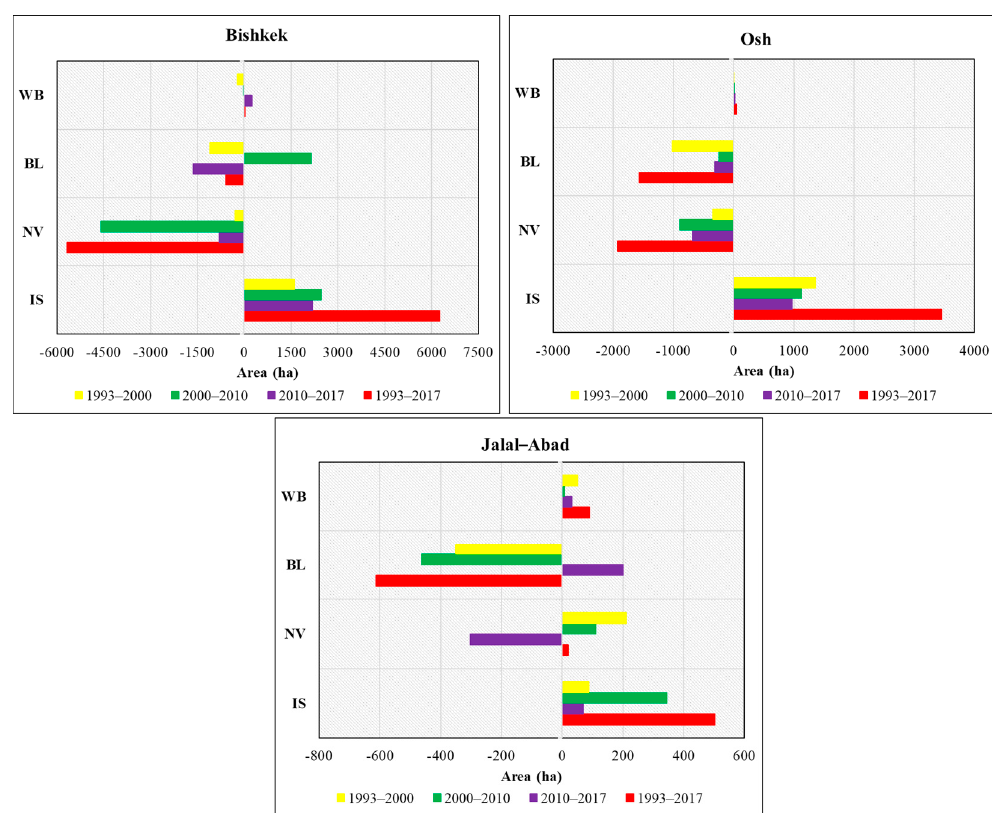
Figure 5. The bar charts showing the changes in the area covered during the study period. Note: IS—impervious surface; NV—natural vegetation; BL—bare land; WB—water body.